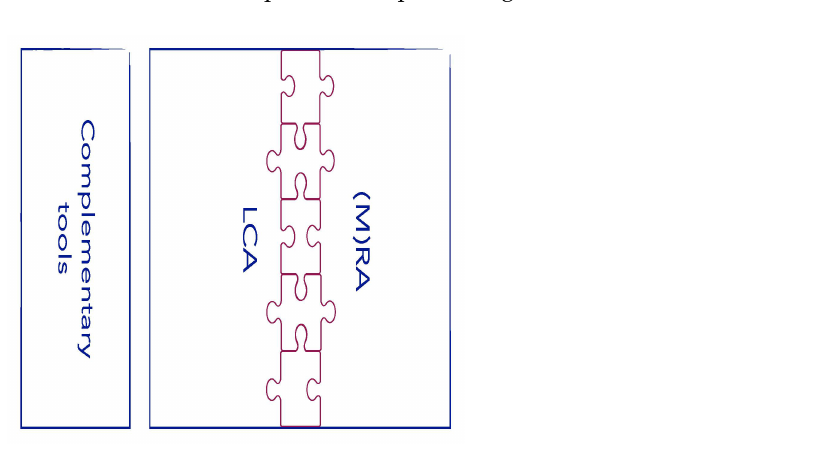
Figure 4. MRA and LCA—complementary tools that can be integrated into a more general approach.